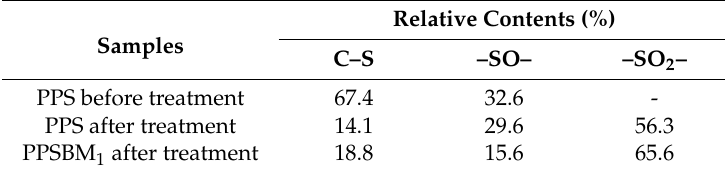
Table 3. Comparison of different functional group in S 2p for PPS and PPSBM 1